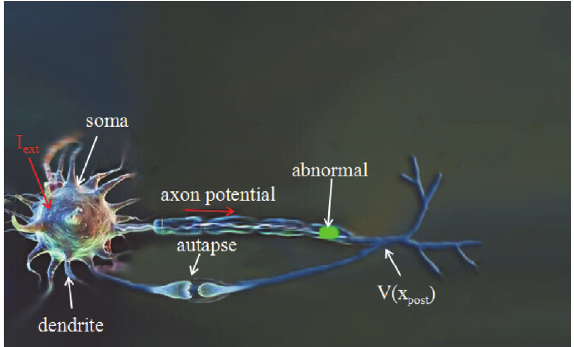
Figure 1: Schematic diagram of injured neuron driven by autapse: action potential is propagated along the axon and the local kinetics of electrical activities will be described by Hodgkin-Huxley neuron model.Abnormalareaontheaxonisgeneratedbyblockingchannels of sodium or potassium; thus the conductance is used as bifurcation parameter. When neuron (axon) is injured, synapse is triggered to form auxiliary loop; thus autapse can be